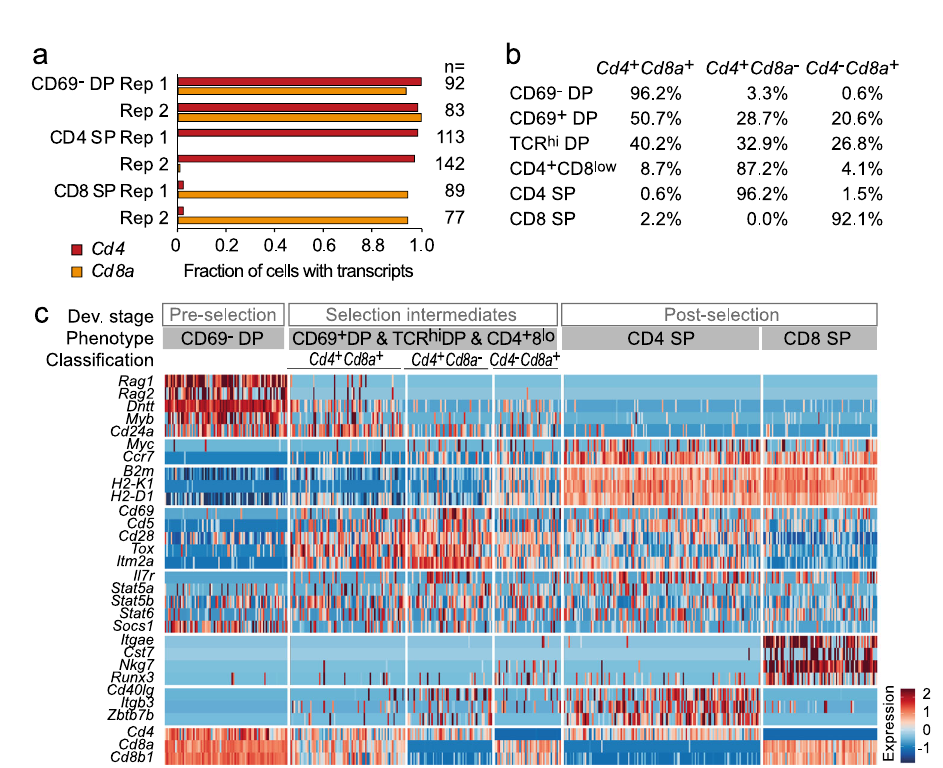
Fig. 2 scRNA-seq reliably detects the coreceptor transcripts Cd4 and Cd8a . a scRNA-seq detection frequencies of Cd4 (red) and Cd8a (orange) in sorted CD69 − DP, CD4 SP and CD8 SP wild-type thymocytes. Bars of the same colour represent independent biological replicates. Cell numbers are listed in Supplementary Table 2. Source data are provided as a Source Data fi le. b Representation of Cd4 + C d8a + , Cd4 + Cd8a − and Cd4 − Cd8a + coreceptor gene expression patterns in by CD69 − DP, CD69 + DP, TCR β hi DP, CD4 + CD8 low , CD4 SP and CD8 SP wild-type thymocytes. c Cells (columns) are grouped by developmental stage (pre-selection, selection intermediates and post-selection) and cell surface phenotype. CD69 − DP represent pre-selection thymocytes, pooled CD69 + DP, TCR β hi DP and CD4 + CD8 low represent selection intermediates, CD4 SP, TCR β hi CD8 SP represent post-selection thymocytes. Selection intermediates are classi fi ed into Cd4 + C d8a + , Cd4 + Cd8a − and Cd4 − Cd8a + based on scRNA-seq detection of Cd4 and Cd8a . The data shown are for replicate 2. See Supplementary Table 7 for cell